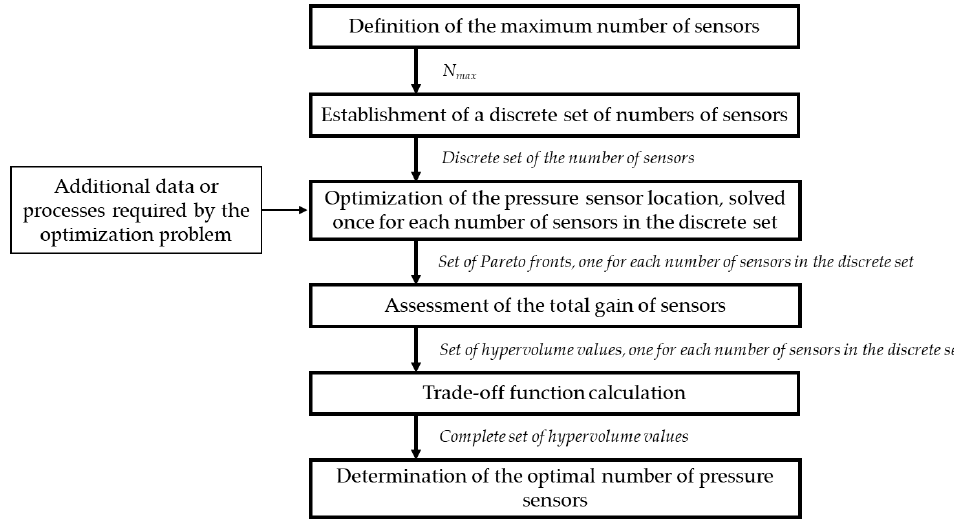
Figure 1. Flowchart of the proposed methodology.